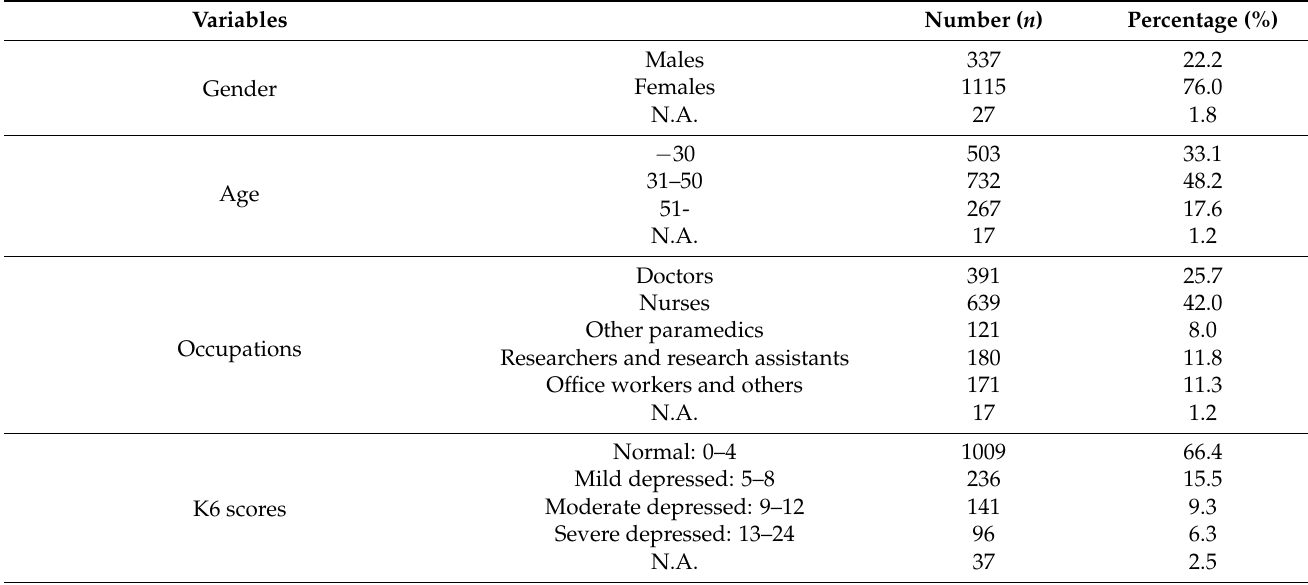
Table 1. Demographic characteristics of the respondents ( N =